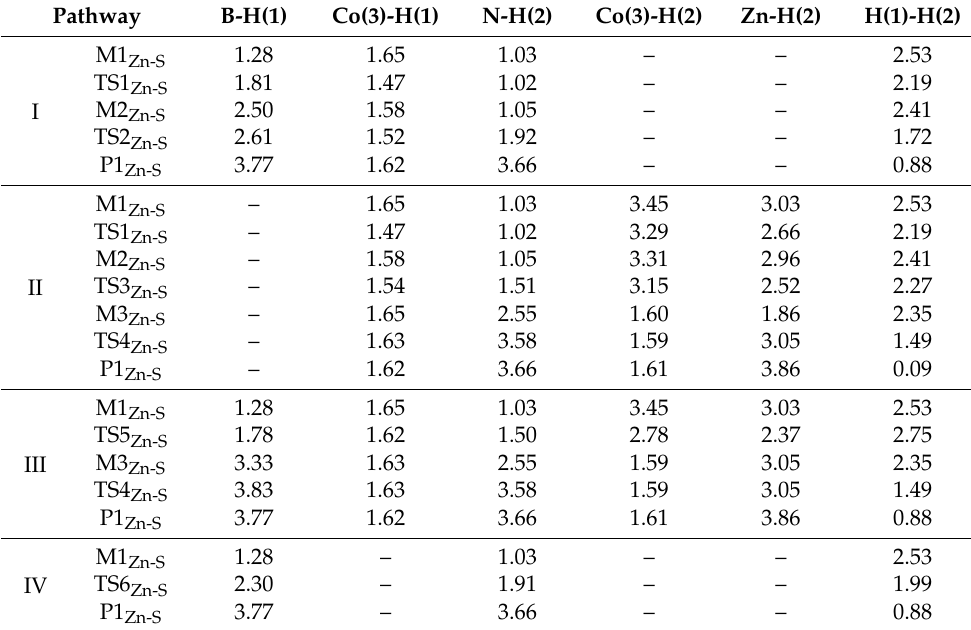
Table 1. The bond length (Å) parameters of reaction sites in CoP Zn-S -catalyzed NH 3 BH 3 hydrogen evolution process. (Å). Pathway